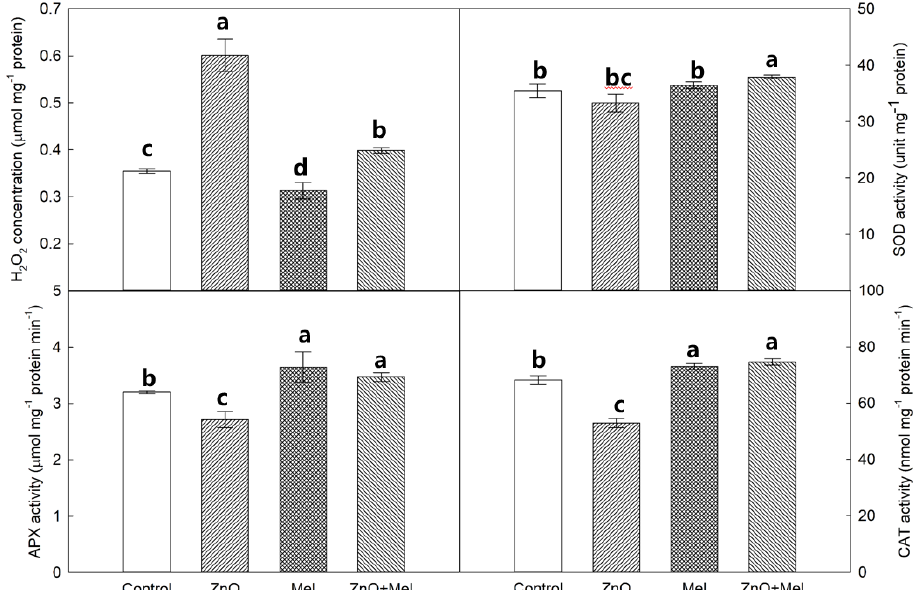
Figure 7. H 2 O 2 concentration and activities of superoxide dismutase (SOD), ascorbate peroxidase (APX) and catalase (CAT) in the last fully expanded leaf in wheat as affected by melatonin application and Zinc Oxide (ZnO) nanoparticles. Mel, melatonin. Data represent the mean ± SE of three replicates. Different letters indicate significant differences ( p < 0.05).